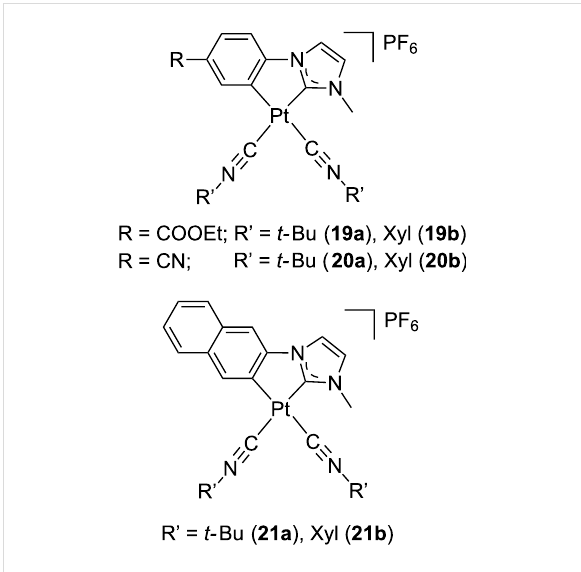
Figure 9: Molecular structure of carbene-containing cyclometallated alkynylplatinum(II) complexes 19 – 21 [41].